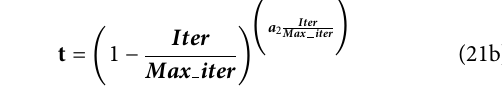
Figure 1 . The speci fi c procedure is carried out as follows: